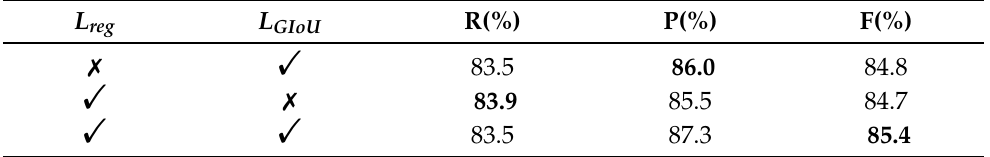
Table 2. Ablation studies: Impact of loss function on detection results on CTW1500.